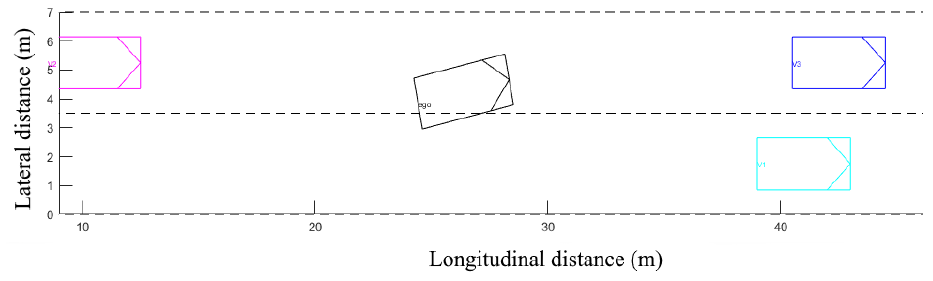
Figure 11. Graphical representation of the driving simulator.